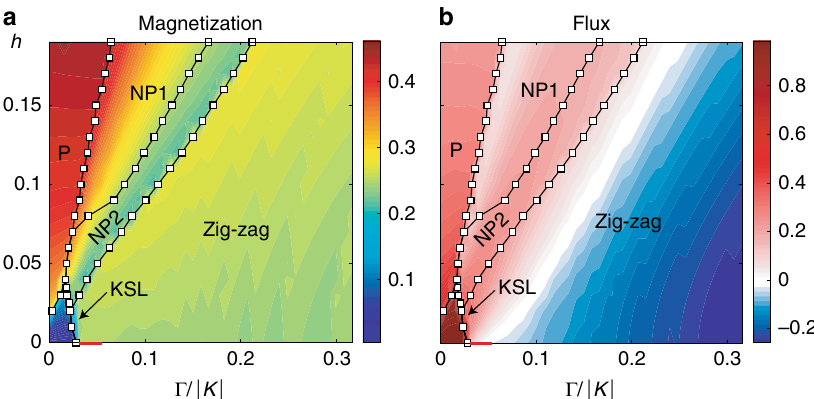
Fig. 1 Ground-state phase diagram. a The magnetization and b the fl ux expectation value of the K - Γ - Γ 0 model. Here KSL stands for the chiral Kitaev spin liquid, P for a spin-polarized phase, and NPs for nematic paramagnet phase. The red solid line at h ¼ 0 denotes a ferromagnetic phase (see text